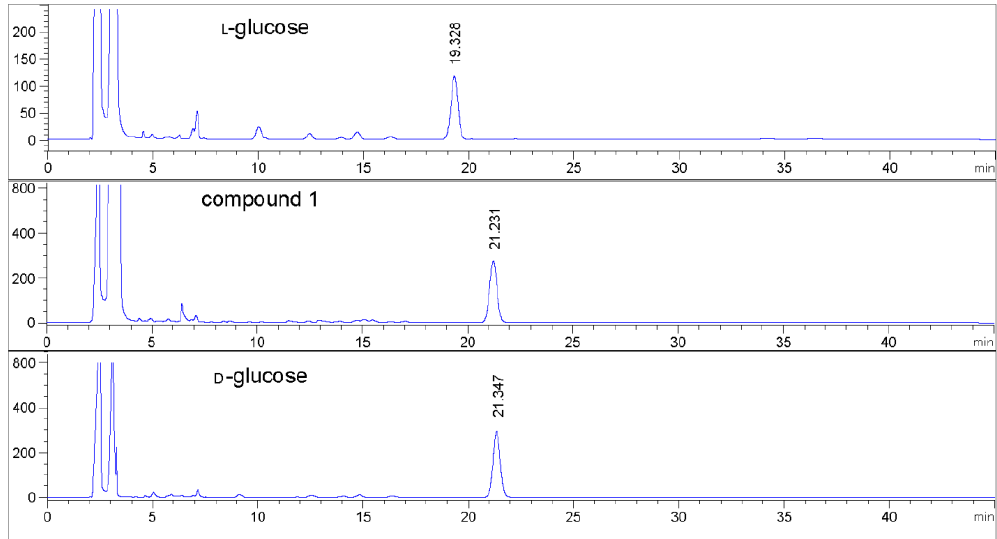
Figure 5. HPLC analytic spectra of glucosyl derivatives.